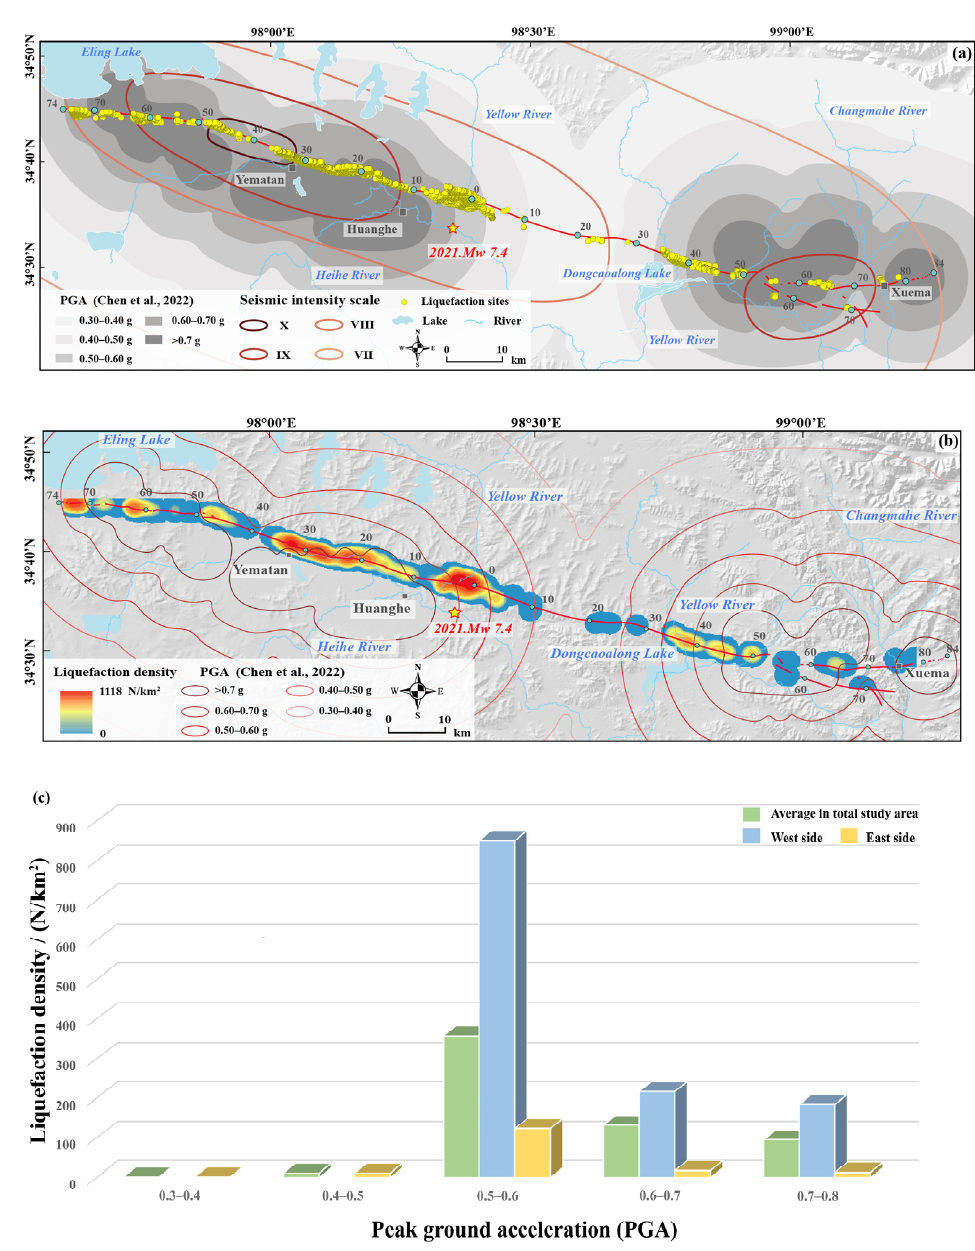
Figure 5. Coseismic soil liquefaction distribution map. ( a ) The yellow points are the coseismic soil liquefaction datasets interpreted based on UAV images, the peak ground acceleration (PGA) data are obtained from Chen et al. [47], and seismic intensity data are obtained from Ministry of Emergency Management of the People’s Republic of China (https://www.mem.gov.cn/xw/yjglbgzdt/202105/t20210528_386251.shtml, accessed on 28 May 2021). ( b ) Density distribution map of coseismic soil liquefaction. ( c ) Liquefaction density in different PGA regions of the Maduo Mw 7.4 earthquake.